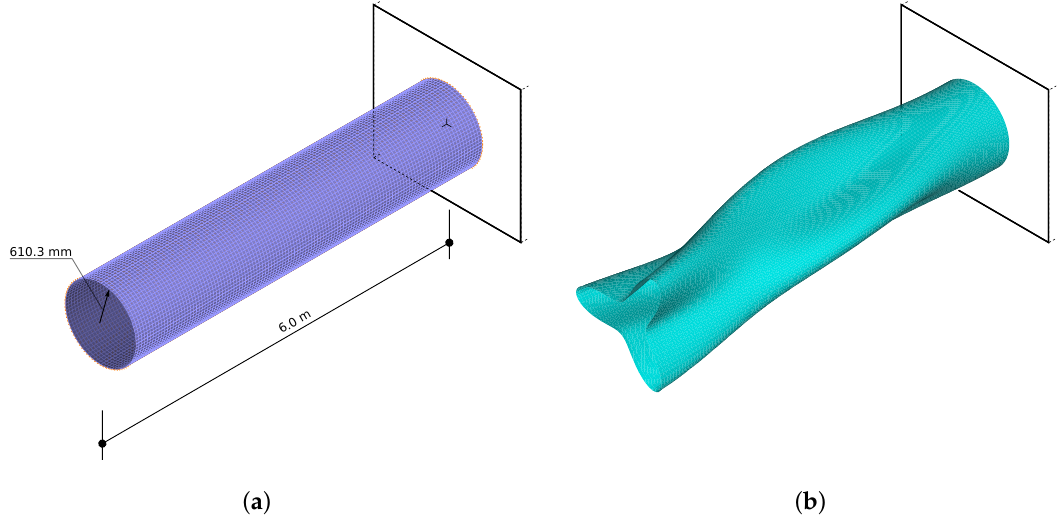
Figure 2. The finite element (FE) model ( a ) and an example of C32 mode shape ( b